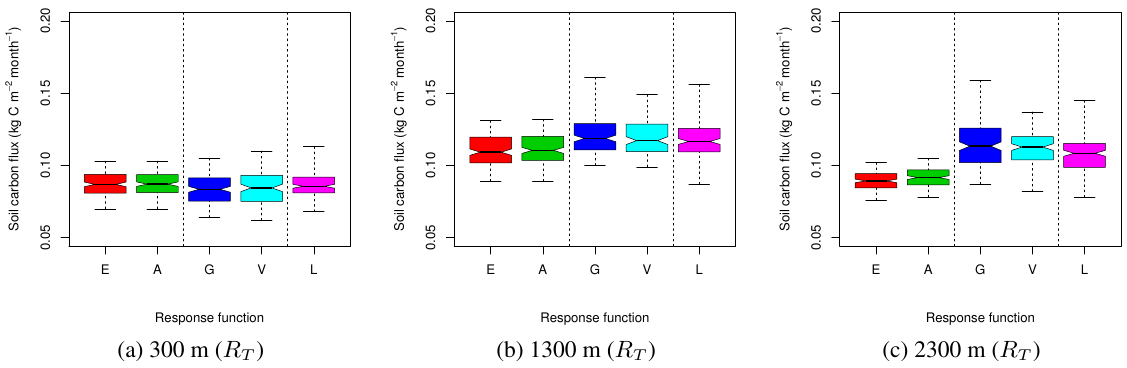
Fig. 3. Uncertainty in short-term soil carbon flux with climate of August 2006 as an example output for the case with only varying temperature response functions ( R T ) on (a) 300m, (b) 1300m and (c) 2300m of elevation. Pairs of response functions and sites have been grouped according to the response formulation used. The box plots show the median, the lower and upper quartiles and span over the 95% confidence interval. Models are separated by the dashed lines into groups with similar means and uncertainty ranges. Abbrevations as in Fig. 1. was comparable with measurements of above ground leaf lit- ter only of 0.12–0.52 kgCm − 2 y − 1 ( Rodeghiero and Cescatti,